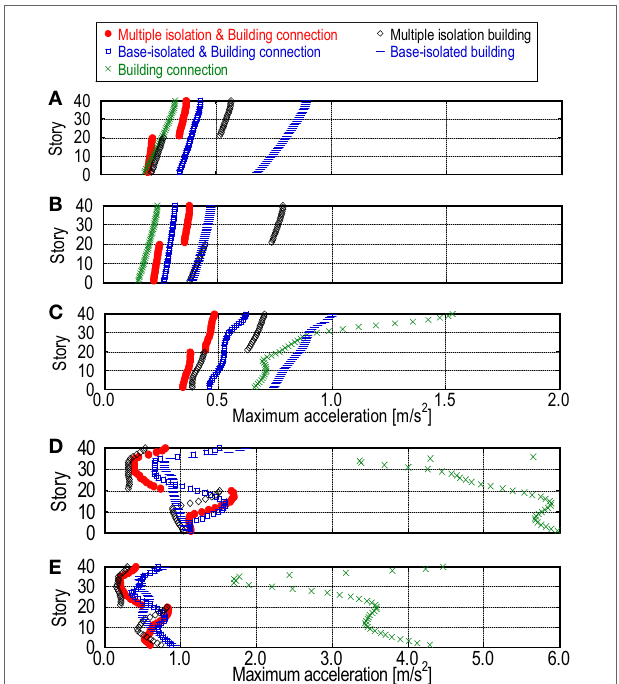
FIGURE 9 | Maximum top-story accelerations under various ground motions: (A) artificial long-period, long-duration ground motion (6.8s), (B) artificial long-period, long-duration ground motion (8.4s), (C) Tomakomai EW (2003), (D) artificial pulse-type ground motion, and (E) JMA Kobe NS (1995) .